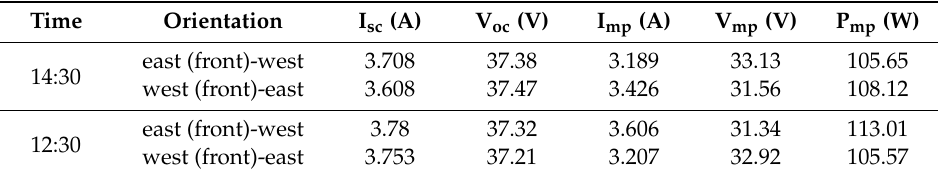
Table 6. Measured I–V curve data at a specific